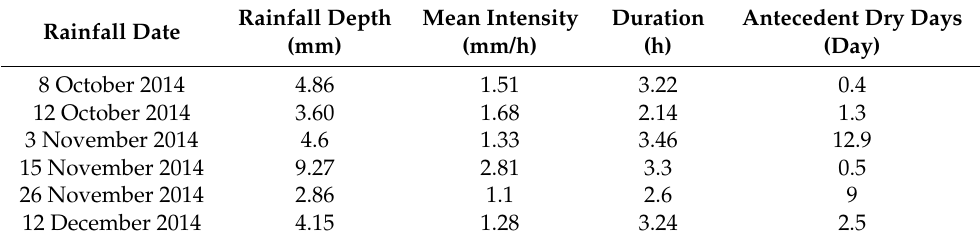
Table 2. Summary of the 6 selected rainfall events.